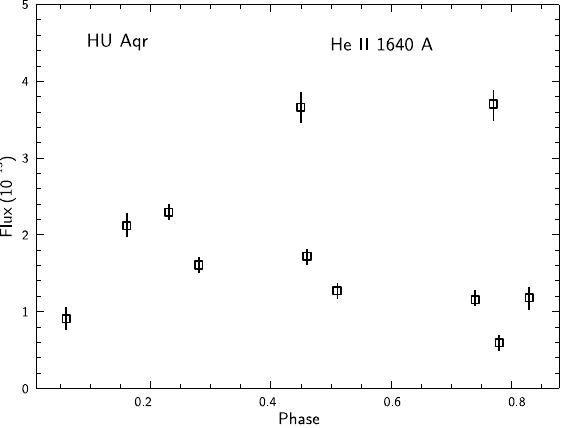
Fig. 10. The same as in Figure 9, but for the He II line.